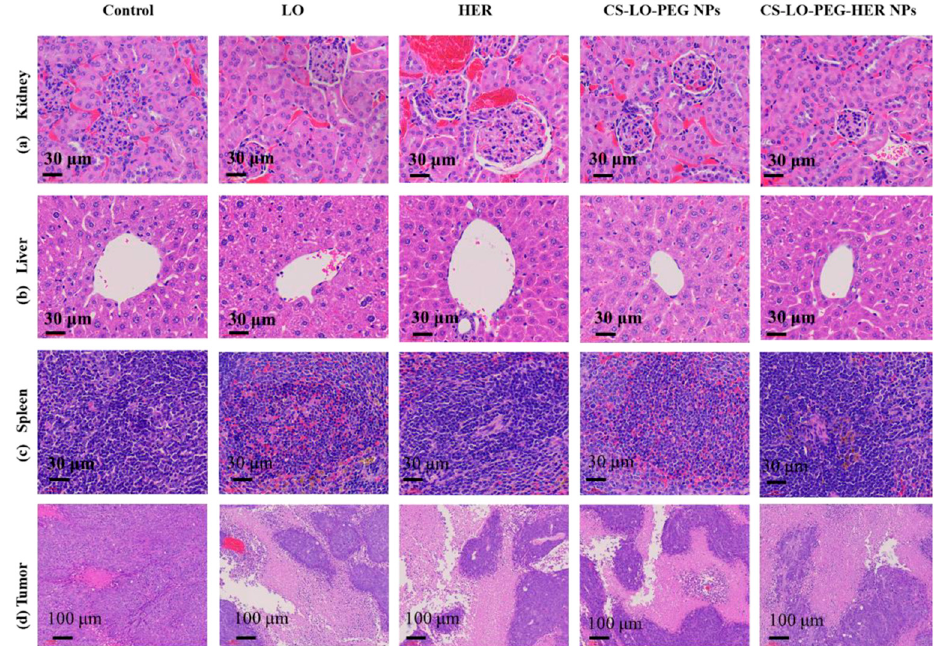
Figure 4. Effect of L-lysine α -oxidase (LO), herceptin (HER), and different chitosan (CS)-polyethylene glycol (PEG) nanoparticle treatments on histopathological changes in organs and tumor pathology: kidney ( a ), liver ( b ), spleen ( c ), and tumor ( d ). Image taken from the work by Saravanakumar et al. [72].